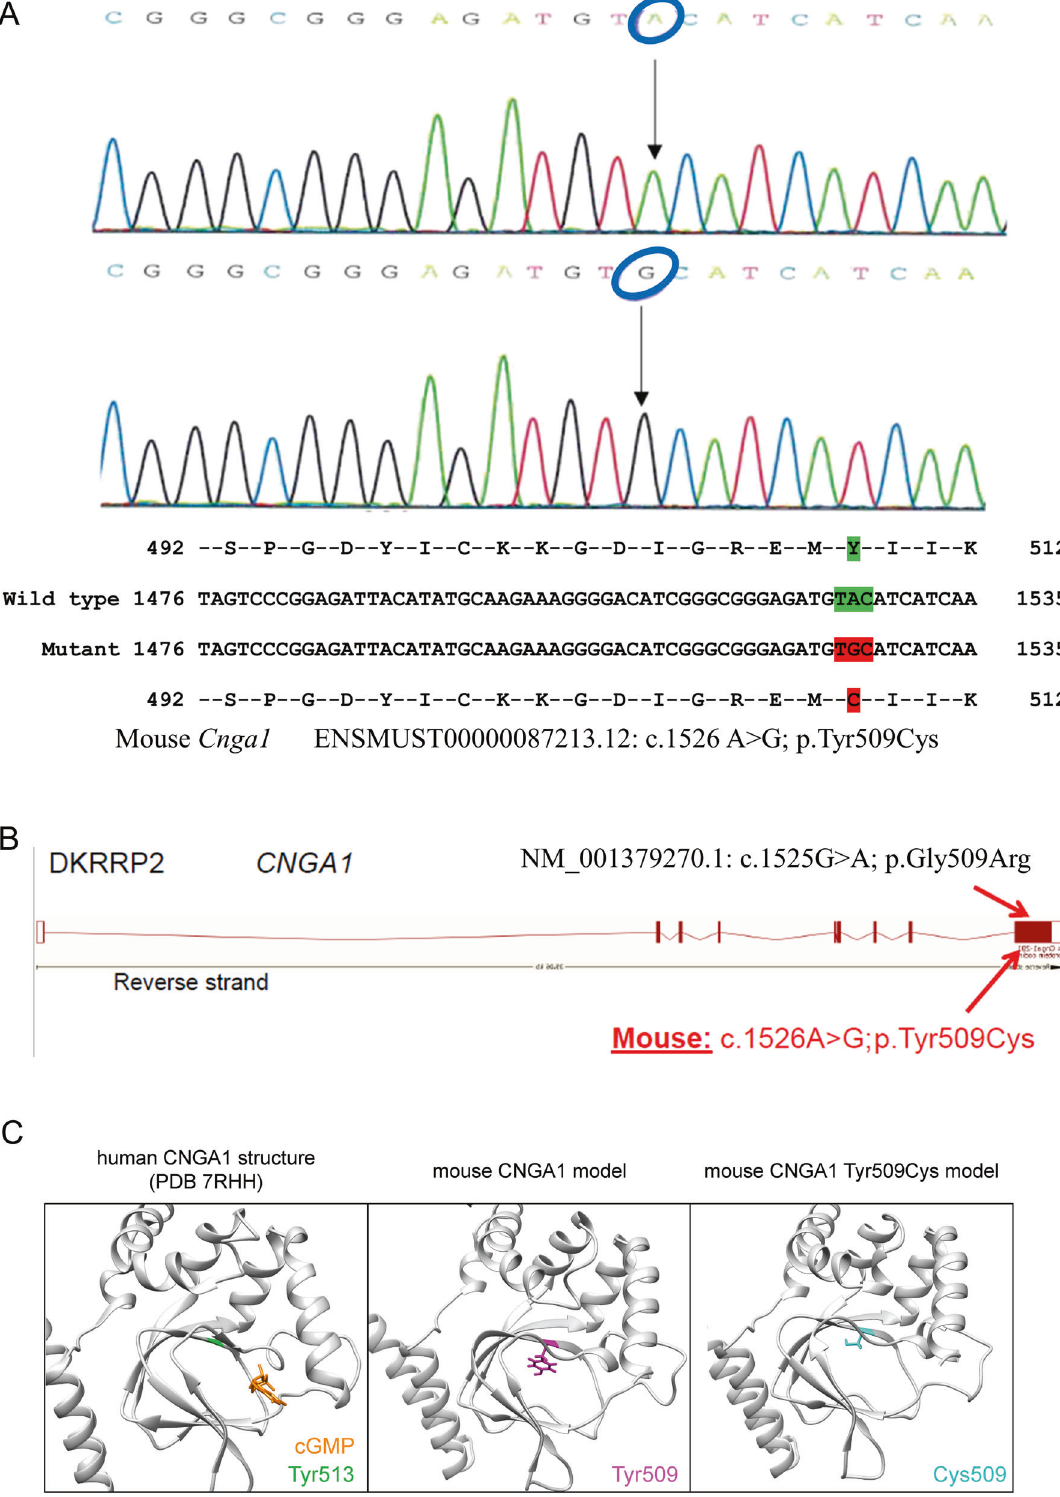
Fig. 3 Cnga1 mouse model. A DNA sequencing shows the mutation in the new mouse model (c. 1526 A > G; blue circles). The missense mutation (marked in red) is compared with the wild-type sequence (marked in green) together with the translated protein sequences of the mouse. B Location of the human (p.Gly509Arg, top) and murine (p.Tyr509Cys, bottom) mutations in the cGMP-binding domain. C Structural comparison of wild-type and mutant murine CNGA1 (backbone is shown in grey). The amino acid of interest in the wild-type structure (Tyr509, magenta) and mutant structure (Cys509, cyan) are shown as atoms. As reference structure, the CNGA1 subunit of the human PDB 7RHH [20] is shown with bound cGMP (orange, shown as atom) and the corresponding amino acid residue Tyr510 is highlighted (green). Models were generated using the RoseTTAfold deep learning algorithm [19] available at https://robetta.bakerlab.org/. The generated 3D models were visualized using the UCSF Chimera software (https://www.cgl.ucsf.edu/chimera/). Cell Death Discovery (2022)